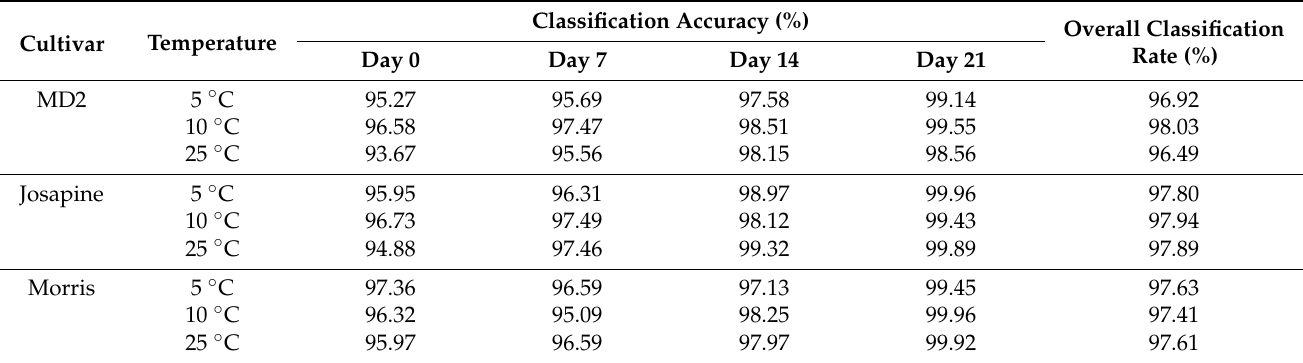
Table 7. Classification performance of pineapple cultivars at different storage days and temperatures using naïve